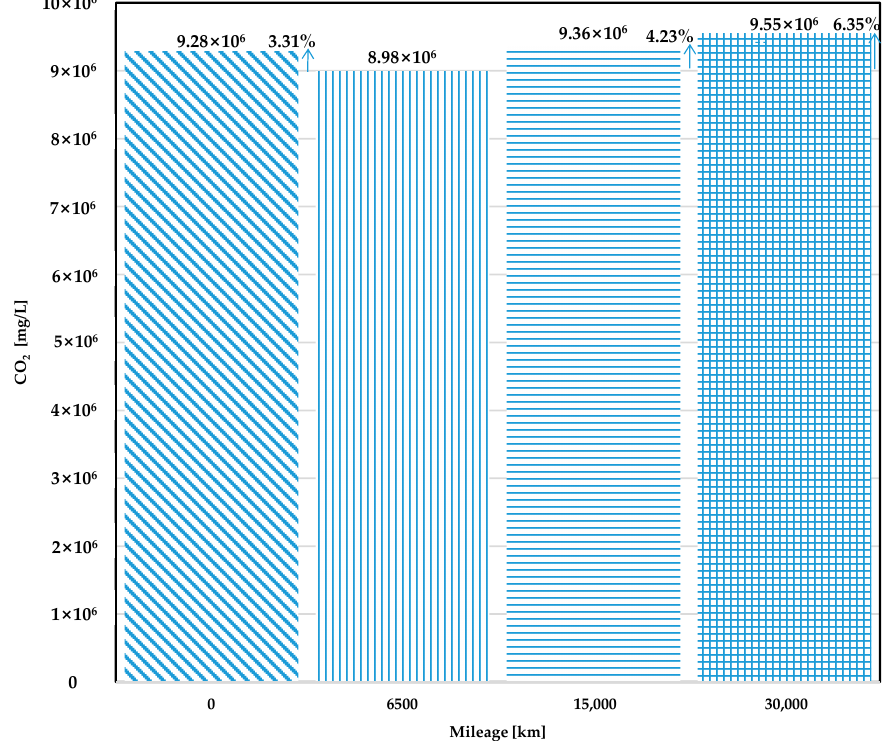
Figure 7. Total CO 2 emissions measured during the HWFET driving cycle according to each mileage.